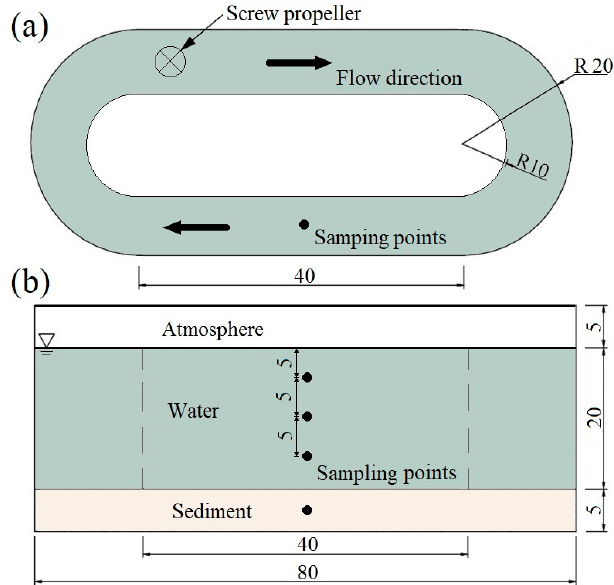
Figure Figure 2. Sketch of the experimental facility (cm) and the sampling points. ( a ) planform; ( b ) side elevation. A screw propeller was used to simulate different velocity conditions by adjusting rotational-speed.